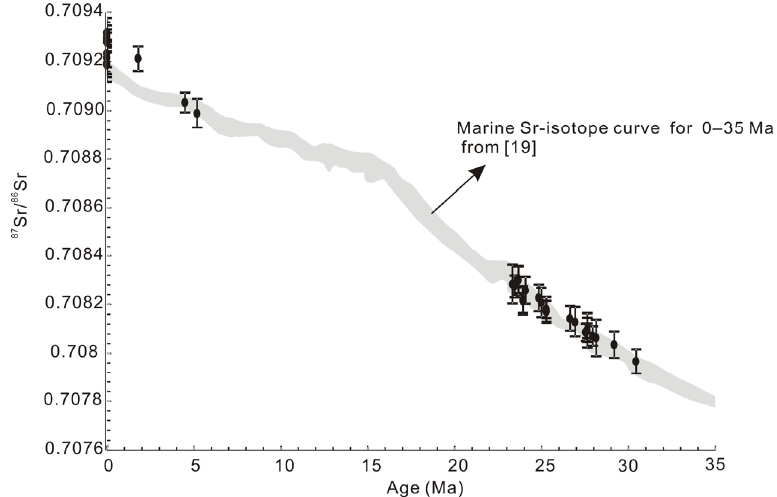
Figure 8. Fish teeth ages obtained from core P10.